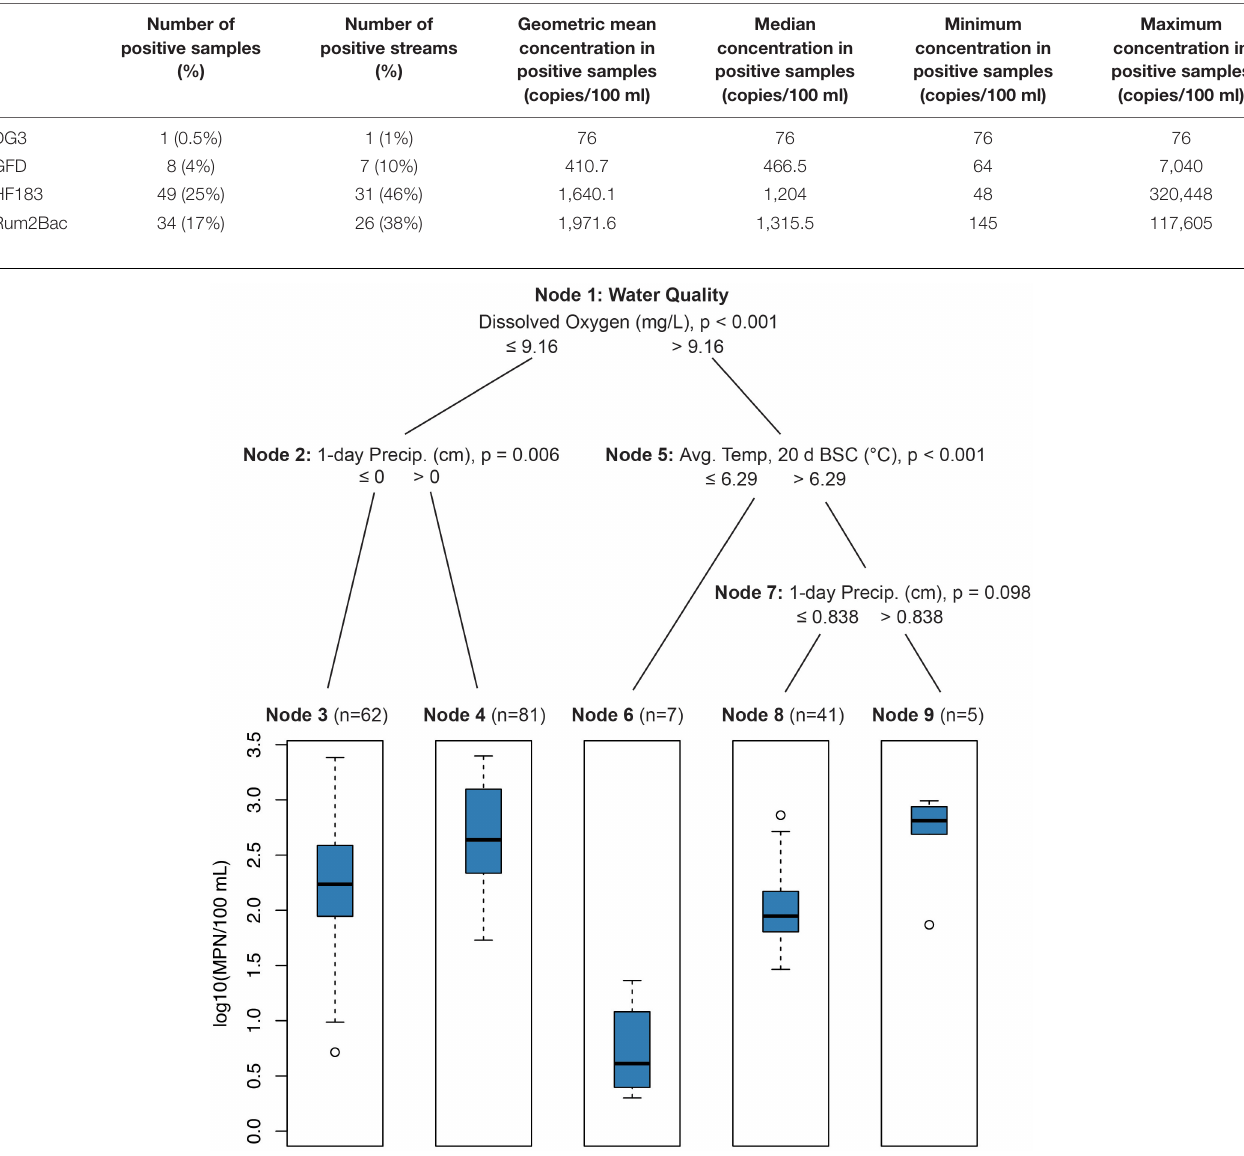
TABLE 1 | Study-wide detection frequency and concentrations of molecular markers.